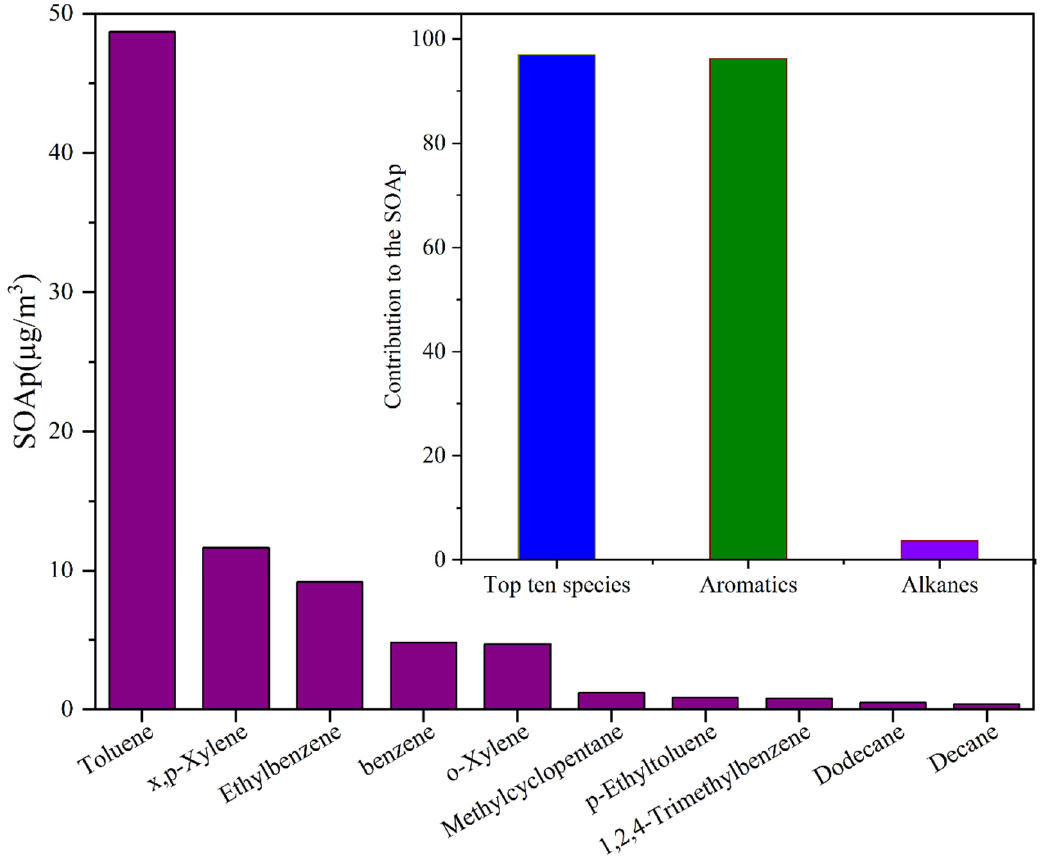
Figure 4. The top ten species that contributed most to